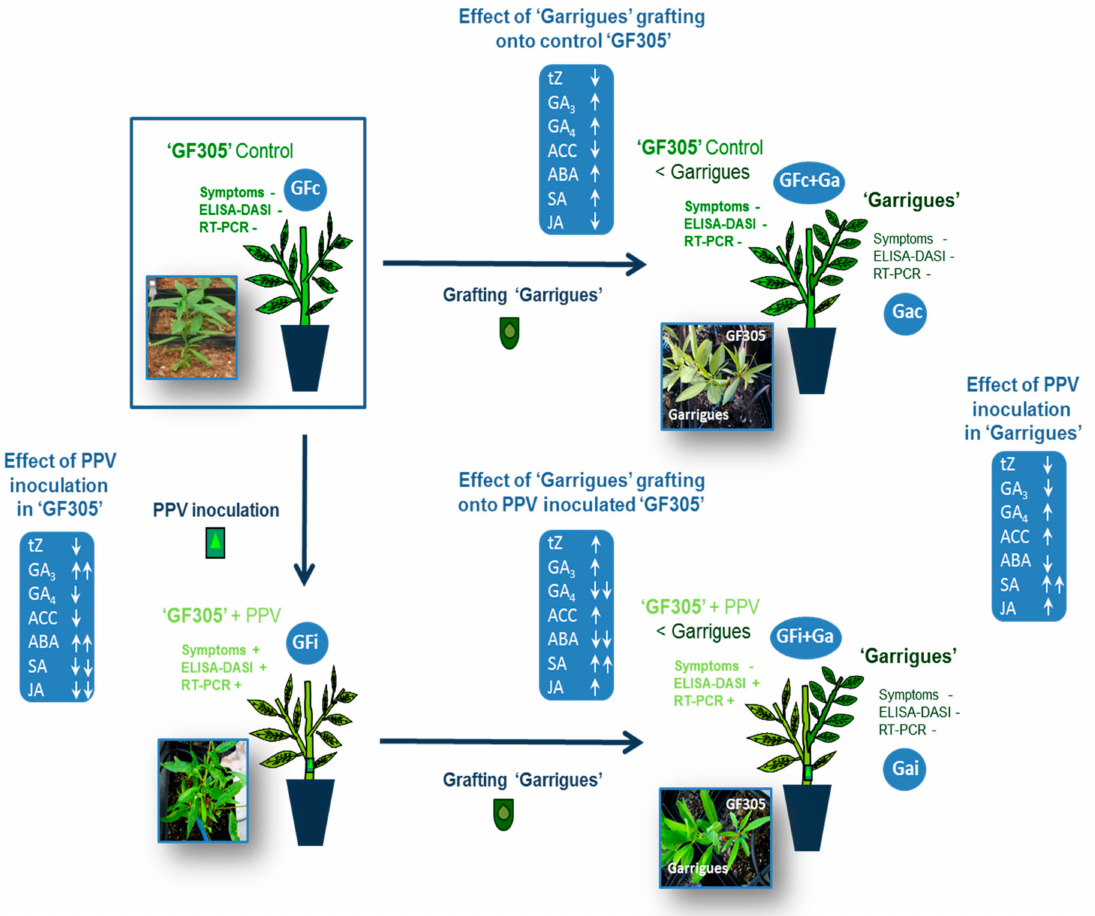
Figure 1. Different plant models tested: GFc = control “GF305” peach rootstock (healthy); GFi = infected “GF305” peach rootstock showing strong sharka symptoms; GFc+Ga = “GF305” peach rootstock grafted with “Garrigues” almond; GFi+Ga = “GF305” peach rootstock infected with Plum pox virus (PPV) without sharka symptoms after being grafted with “Garrigues” almond. Gac = Garrigues almond grafted onto healthy “GF305” rootstock; and Gai = Garrigues almond grafted onto infected “GF305” rootstock. ABA (abscisic acid); ACC (1-aminocyclopropane-1-carboxylic acid); DASI (Double antibody sandwich indirect); GA 3 (gibberellin 3); GA 4 (gibberellin 4); JA (jasmonic acid); SA